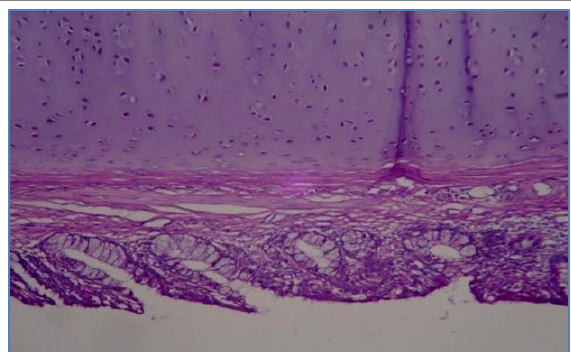
Figure, 1: Histopathological section in infected trachea shows vacuoltion in the epithelial cells ( ), hyperplasia and hypertrophy in goblet cell of mucosal gland ( ), lymphocytes infiltration ( ) and containing intranuclear inclusion bodies ( ) 72 hrs. post infection (H and E) (400X).